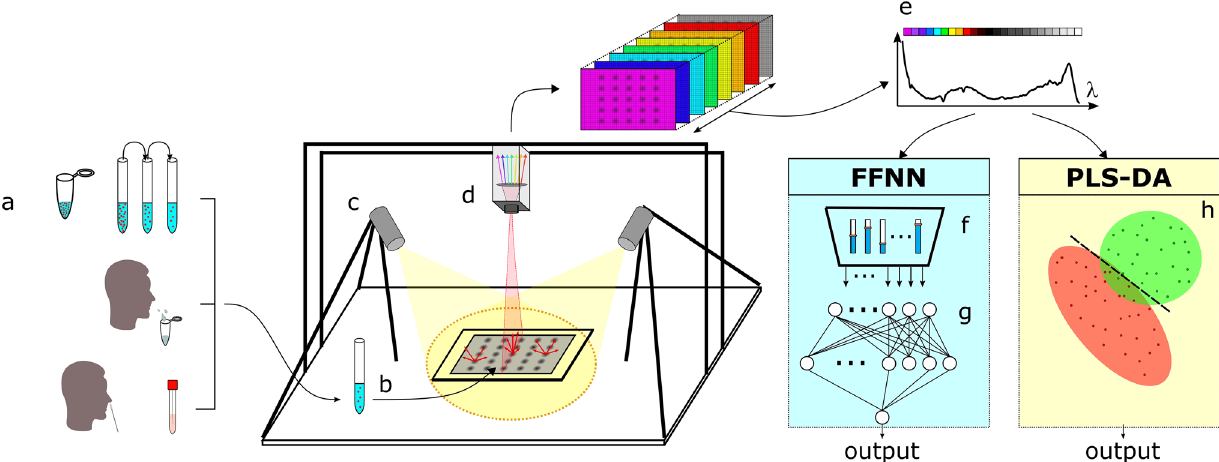
Figure 1. Schematic of the hyperspectral imaging assay. ( a ) Three different types of samples were analyzed. Top, samples containing spike pseudotyped lentiviral particles (i.e., synthetic coronaviruses). Middle, human saliva of SARS-CoV-2 suspects. Bottom, inactivated nasopharyngeal swabs for SARS-CoV-2 PCR tests. ( b ) Several fluid droplets were placed on a supporting plate. ( c ) The samples were illuminated using two halogen lamps. Sub-surface scattering is illustrated by the red arrows. ( d ) A sliding sensor recorded hyperspectral images the VNIR range. ( e ) The reflectance spectrum of each pixel within the hyperspectral matrix was then digitally pre-processed to obtain the pseudo-absorbance spectra. ( f ) Spectral features descriptors were obtained from pixel spectra for analysis. ( g ) A feed-forward neural network (FFNN) was trained 37 to detect viral content from spectral features and output a pixel-based binary classification. ( h ) A partial least square-discriminant analysis (PLS-DA) was performed 37 using pixel reflectance